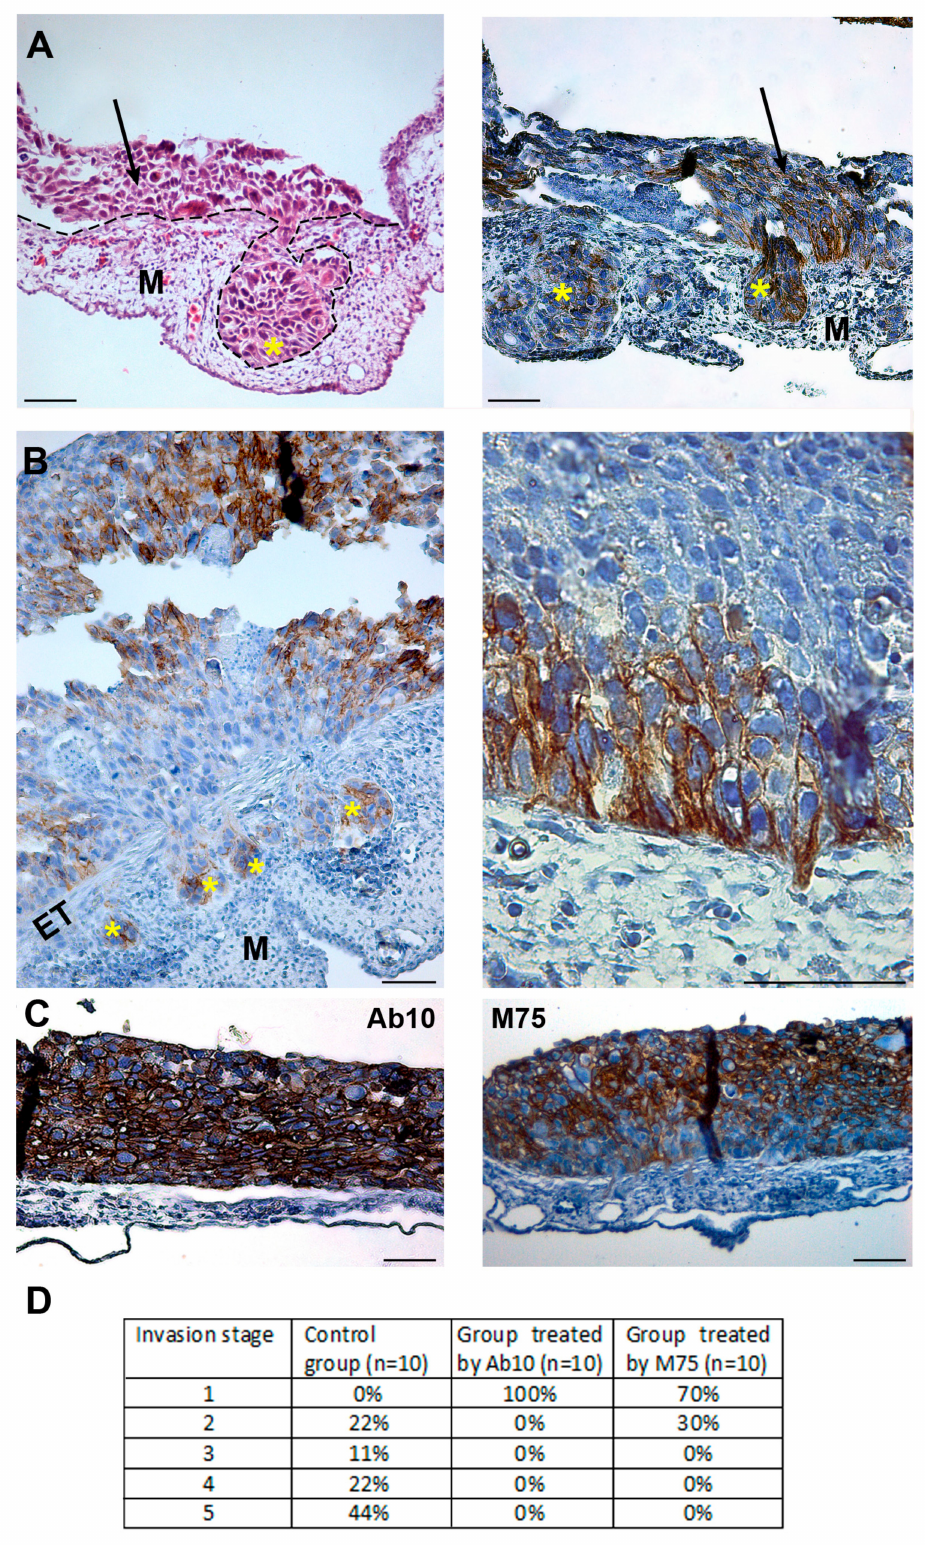
Figure 5. The e ff ect of CAIX on invasion of hypoxic tumor cells in the quail chorioallantoic membrane (CAM) model. Hypoxia pre-incubated TE-1 cells (48 h, 1% O 2 ) were grafted onto the day 7 quail embryo and cultivated ex ovo for 3 days. Hematoxylin and Eosin staining, and imunohistochemical staining of CAIX. ( A ) Hypoxic tumor cells (outlined by dashed line) invaded into CAM and formed metastatic foci (marked by asterisks) in the mesoderm (M) which are positive for CAIX staining.